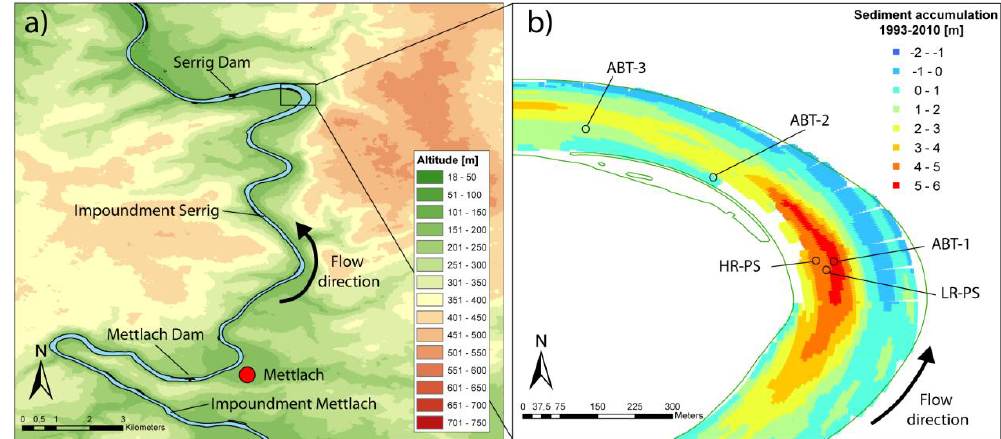
Figure 1. Location of the sampling sites. (a) Topographic map of the Serrig impoundment (49.576 ◦ N, 6.600 ◦ E), which is enclosed by the upper dam in Mettlach and the lower dam in Serrig. The sampling sites are located ∼ 1 to 2km upstream of Serrig dam in the inner bending of the river meander. (b) Map of the sampling sites showing sediment accumulation within the Serrig impoundment (Maeck et al., 2013). The positions of deployment sites for three automatic bubble traps (ABT 1 to 3), the high-resolution pressure sensors (HR-PS) and the low-resolution pressure sensor (LR-PS) are indicated.